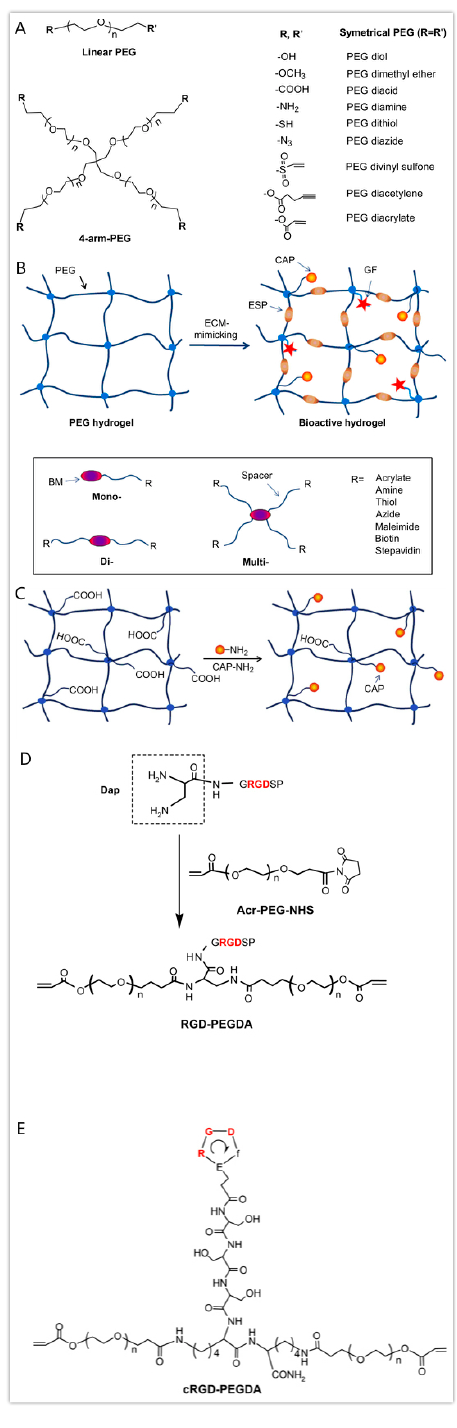
Figure 8. Structure and modification of polyethylene glycols (PEGs) [136]. ( A ) Structures of linear PEG and 4-arm-PEG with various functional end groups. ( B ) Bioactive modification of PEG hydrogels with bioactive molecules (BMs), such as cell-adhesive peptide (CAP), enzyme-sensitive peptide (ESP) and growth factor (GF), and major types of bioactive monomers from mono-, di- and multi-functionalization of BMs with various groups. ( C ) Fabrication of cell-adhesive PEG hydrogels by copolymerization of PEGDA and acrylic acid, followed by post-grafting of cell-adhesive peptides (CAPs) on the hydrogel surface through the reaction between the N-terminal amino groups of CAPs and the carboxyl groups provided by acrylic acid from the hydrogel. ( D ) Synthesis of RGD-containing PEGDA (RGD-PEGDA). ( E ) structure of cRGD-containing PEGDA